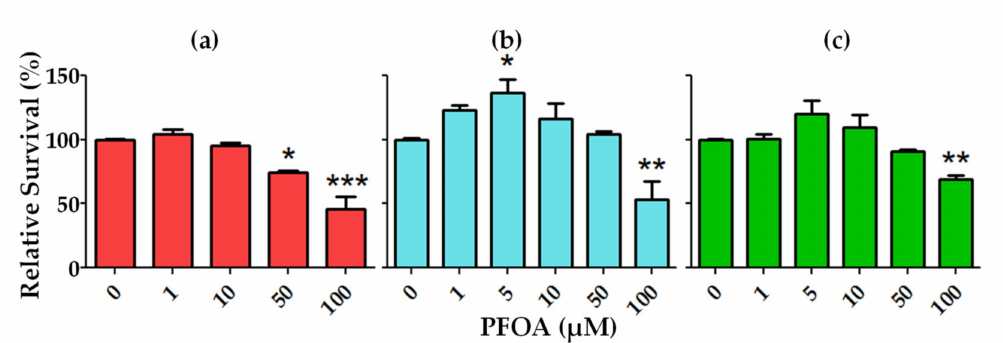
Figure 1. Cell survival after treatment with indicated concentrations of PFOA. Mouse Sertoli TM4 ( a ), mouse type B spermatogonia GC-1 ( b ), and mouse pre-meiotic spermatocyte GC-2 ( c ) cell lines (obtained from ATCC) were plated in triplicate in a 96-well plate at a density of 20,000 cells/well and incubated overnight. Cells were treated with PFOA at 5 different concentrations ranging from 0 µ M to 100 µ M followed by an incubation period of 3–4 days. Cell proliferation (MTT) assay was performed. Displayed data are from at least two individual experiments, mean ± standard error (SEM). Significance was calculated using one-way ANOVA with Dunnett’s post-test. * p value < 0.05, ** p value < 0.01, *** p value <